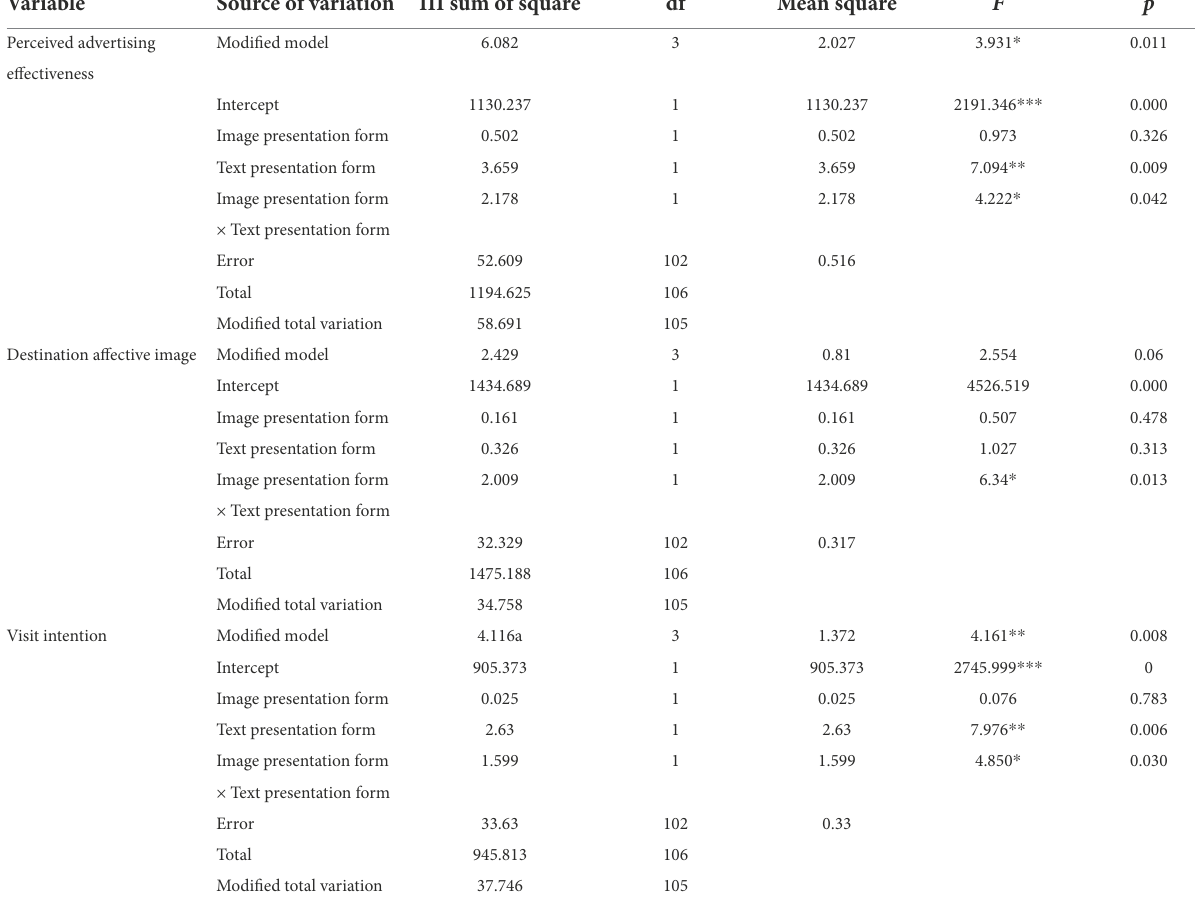
TABLE 3 Multi-factor analysis of variance.